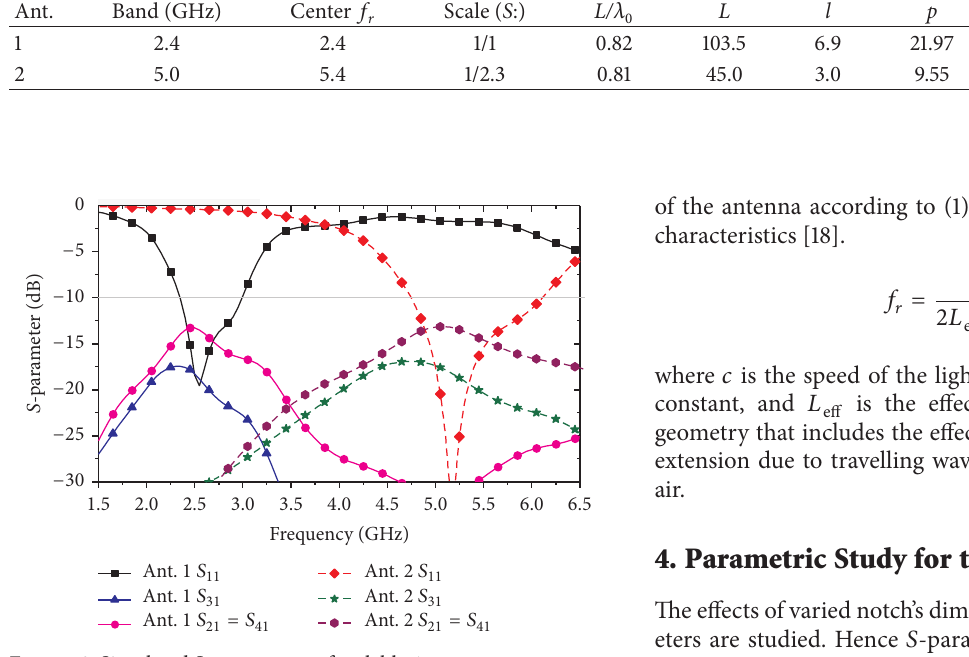
antenna designs. This means that the antenna systems have high isolation for efficient multiport operations without using any additional structure thanks to the orthogonal design of